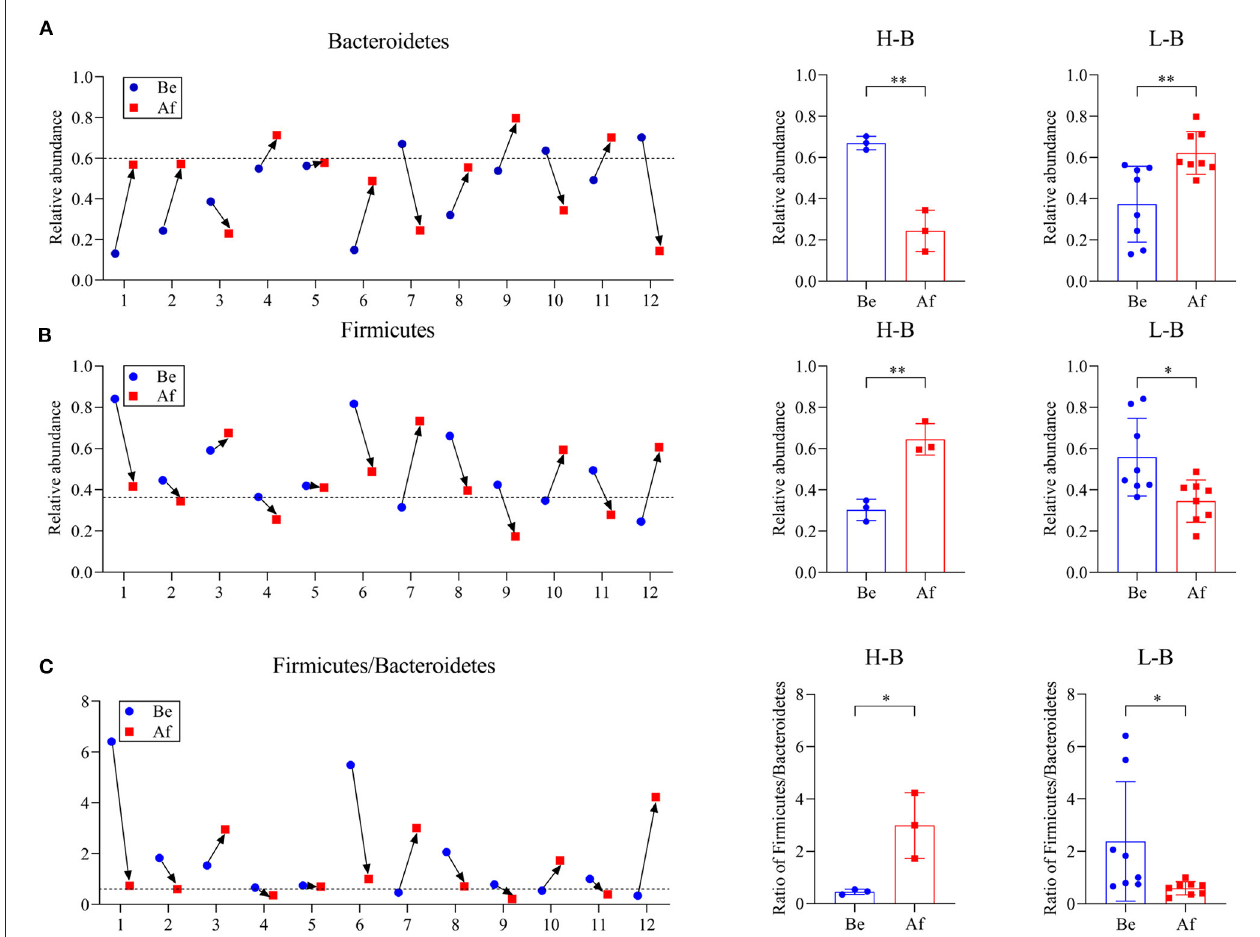
FIGURE 2 | The phylum Bacteroidetes abundance (A) , phylum Firmicutes abundance (B), and Firmicute/Bacteroidetes ratio (C) in individuals Be and Af the 14-day dietary L. japonica intake and the comparations of microbiota abundance in the H-B group and the L-B group. H-B group, original Bacteroidetes abundance higher than 0.6; L-B group, original Bacteroidetes abundance lower than 0.6. * p < 0.05 and ** p <